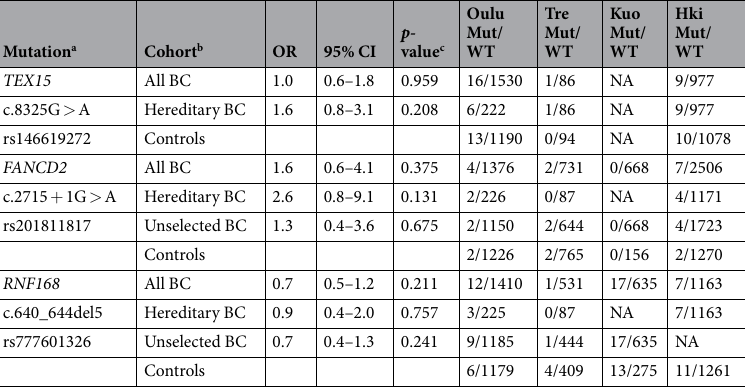
Table 2. Meta-analyses combining Oulu, Tampere, Kuopio and Helsinki screening results. a TEX15 c.7253dupT was excluded from the meta-analysis since the mutation was present only in the Northern Finnish cohort. b All the known BRCA1/2 carriers were excluded from the meta-analyses. c Logistic regression model, all the analyzed cohorts combined and all individual datasets exploited. CI: confidence interval, BC: breast cancer, Hki: Helsinki, Kuo: Kuopio, Mut: mutation carrier, NA: not available, OR: odds ratio, Tre: Tampere, WT: wild type.